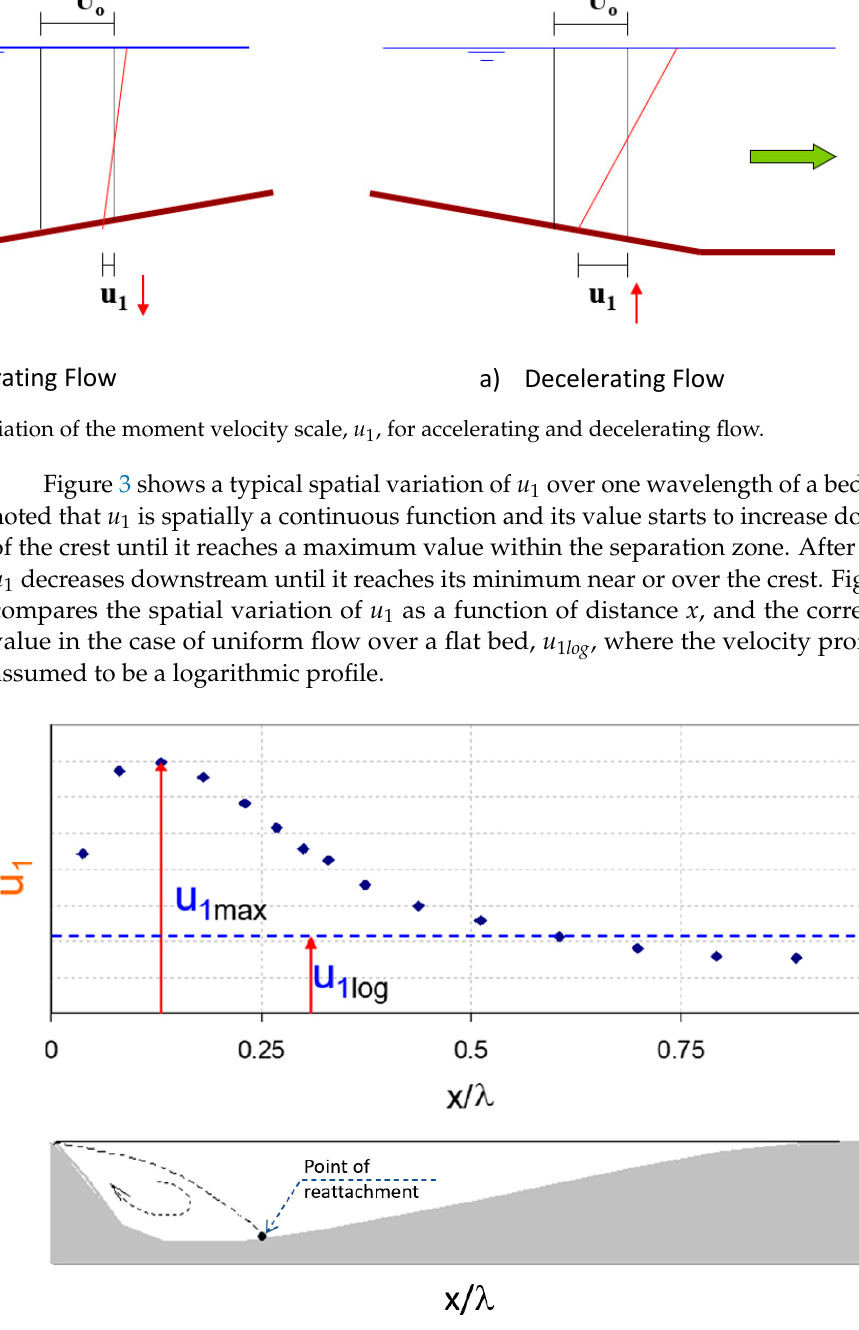
Figure 3. Typical spatial variation of u 1 above a bedform.